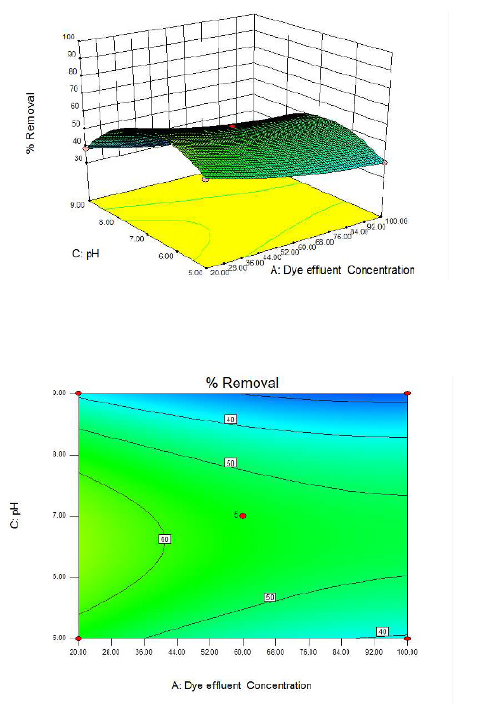
Figure 4. 3D Response surface (Top) and contour plots (Bottom) showing the interaction between Dye effluent concentra- tion and pH for solar induced photocatalytic decolouriza- tion of dye effluent (Catalyst dosage 125 mg L − 1 ; Irradia- tion Time 60